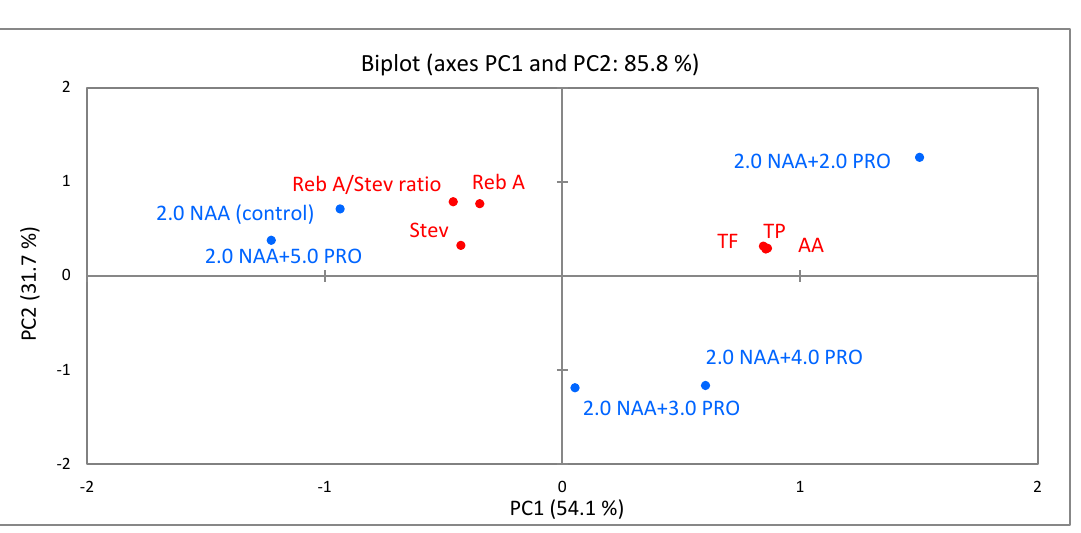
A), rebaudioside A/stevioside ratio (reb A/Stev ratio), and antioxidant activity (AA) in cellular (Reb A), rebaudioside A / stevioside ratio (reb A / Stev ratio), and antioxidant activity (AA) in cellular